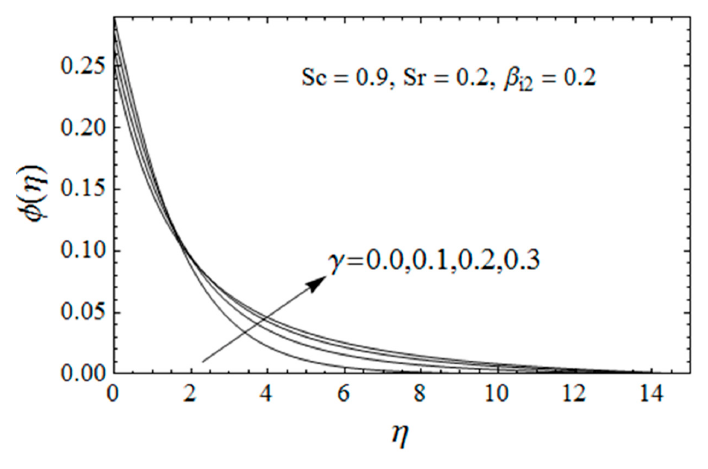
Figure 7. 𝜙(𝜂) for different 𝛾. Figure 7. φ ( η ) for di ff erent γ .